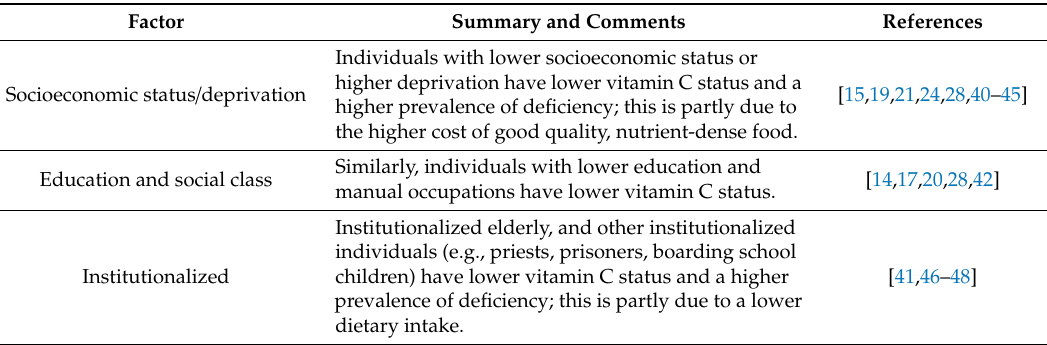
Table 2. E ff ect of socioeconomic factors on vitamin C